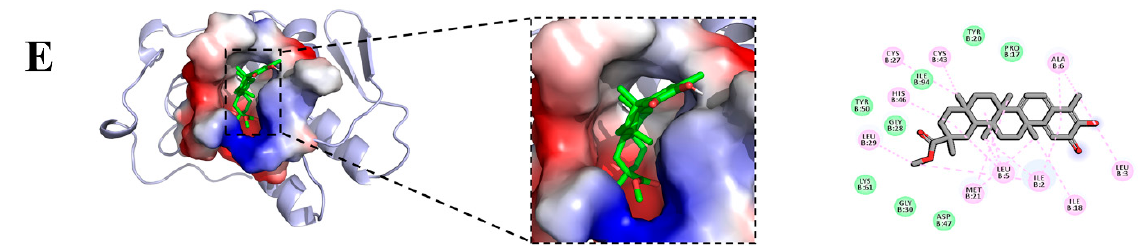
Figure 4. ( A )The PPI network based on 23 potential key targets of pristimerin for RA; ( B ) The bubble chart of KEGG enrichment based on 23 potential key targets. ( C , D ) Effects of pristimerin on MAPK/Erk1/2 and PI3K/Akt pathways. Glyceraldehyde-3-phosphate dehydrogenase (GAPDH) was used as an internal control. Results were presented as the mean ± standard derivations in Western blotting assay. ( E ) Binding of TNF- α with pristimerin and the inset showing the principal interactive residues of pristimerin at the TNF- α binding pocket. * p < 0.05 compared with TNF- α group; *** p < 0.001 compared with TNF- α group, ### p < 0.001 compared with CON group.